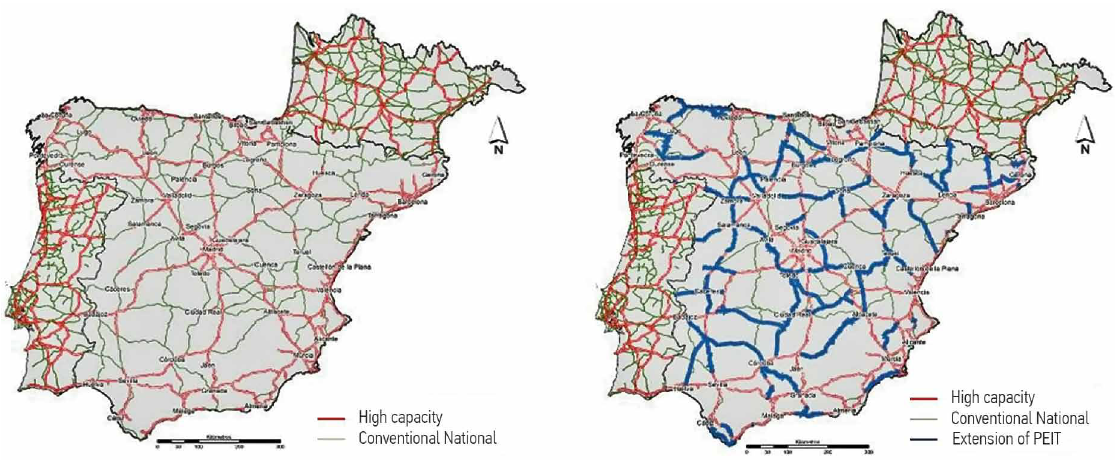
Fig. 1. Road networks in the reference (2005) and PEIT (2020) scenarios